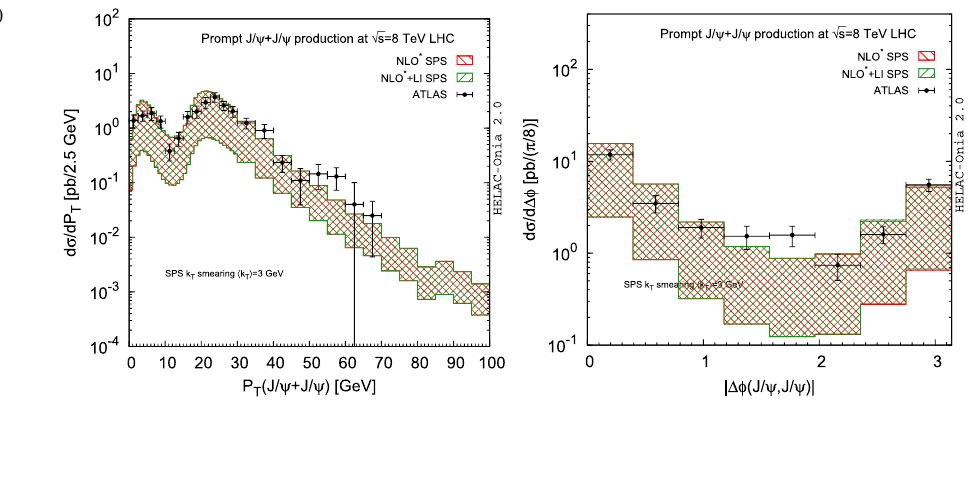
Fig. 12 P T ( J /ψ + J /ψ) (top) and Δφ( J /ψ, J /ψ) (bottom) distributions for CS SPS in √ s = 8 TeV ATLAS